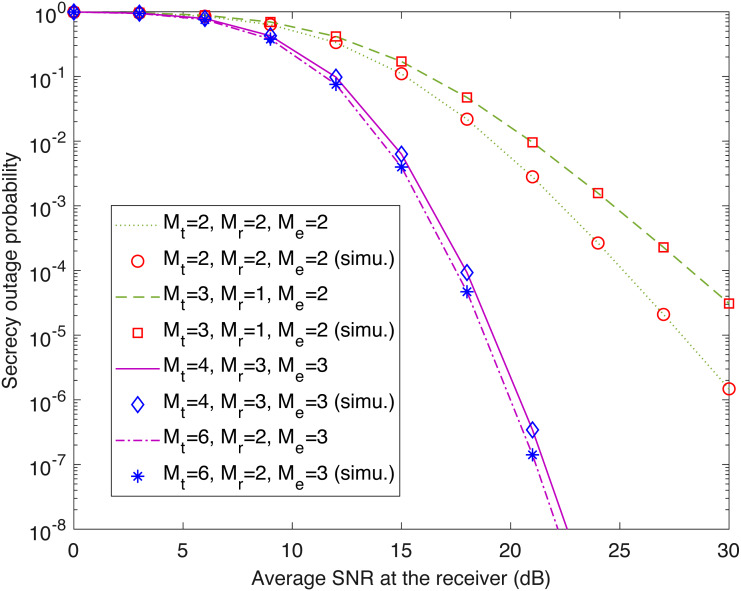
Secrecy outage probability of transmit-receive diversity system (Pout,TR) as a function of \documentclass[12pt]{minimal}
\usepackage{amsmath}
\usepackage{wasysym}
\usepackage{amsfonts}
\usepackage{amssymb}
\usepackage{amsbsy}
\usepackage{upgreek}
\usepackage{mathrsfs}
\setlength{\oddsidemargin}{-69pt}
\begin{document}
}{}${\bar {\gamma }}_{\text{r}}$\end{document}γ ¯r.This figure shows the theoretical and simulated secrecy outage curves for the transmit-receive diversity system with different numbers of antennas at the transmitter (Mt), the legitimate receiver (Mr), and the eavesdropper (Me). The simulation results are labeled with “simu.”.